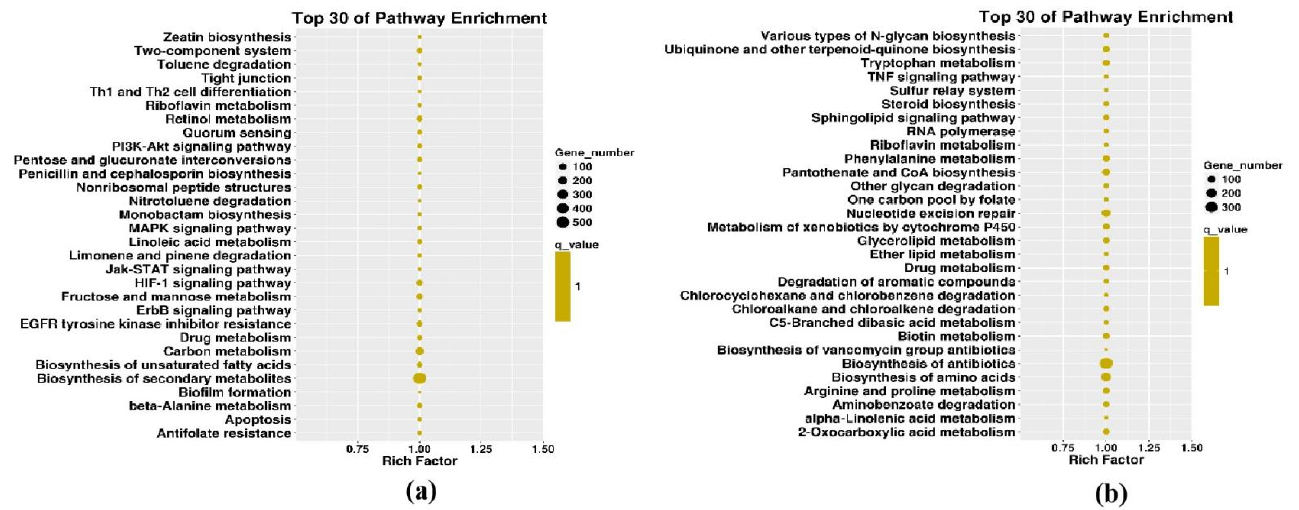
Figure 5. KEGG pathway enrichment from DNA-A- and DNA-B-derived sRNA in S-AB. ( a ) DNA-A-derived sRNA target-enriched KEGG pathways in S-AB. ( b ) DNA-B-derived sRNA target-enriched KEGG pathways in S-AB.